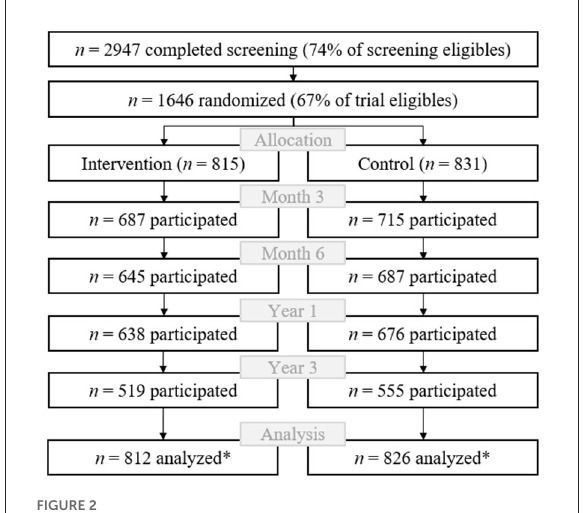
FIGURE2 Participant flow. * n = 8 participants identified as having possible alcohol use disorder were